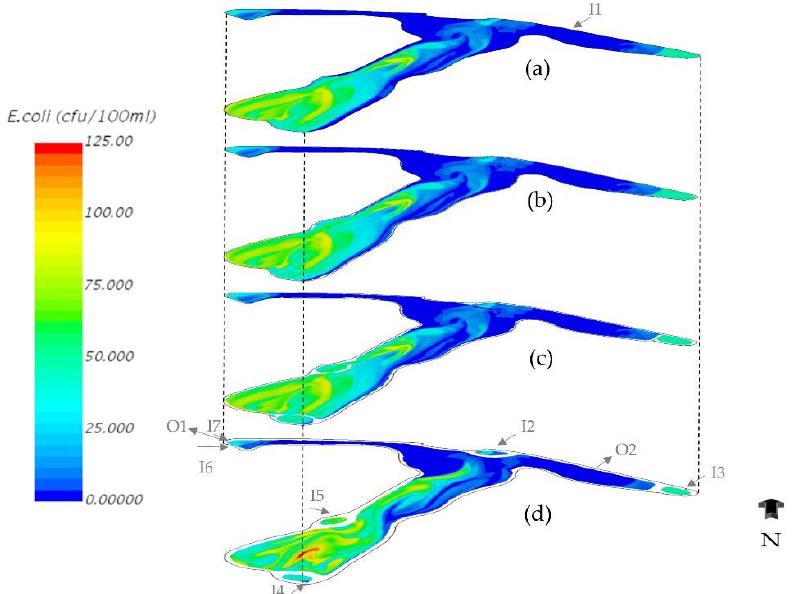
Figure 7. The vertical profile of E.coli concentration on 26 August 2007 at 11 p.m. ( a ) on the surface, ( b ) at 0.5 m below the surface, ( c ) at 1 m below the surface, and ( d ) at 2 m below the surface.